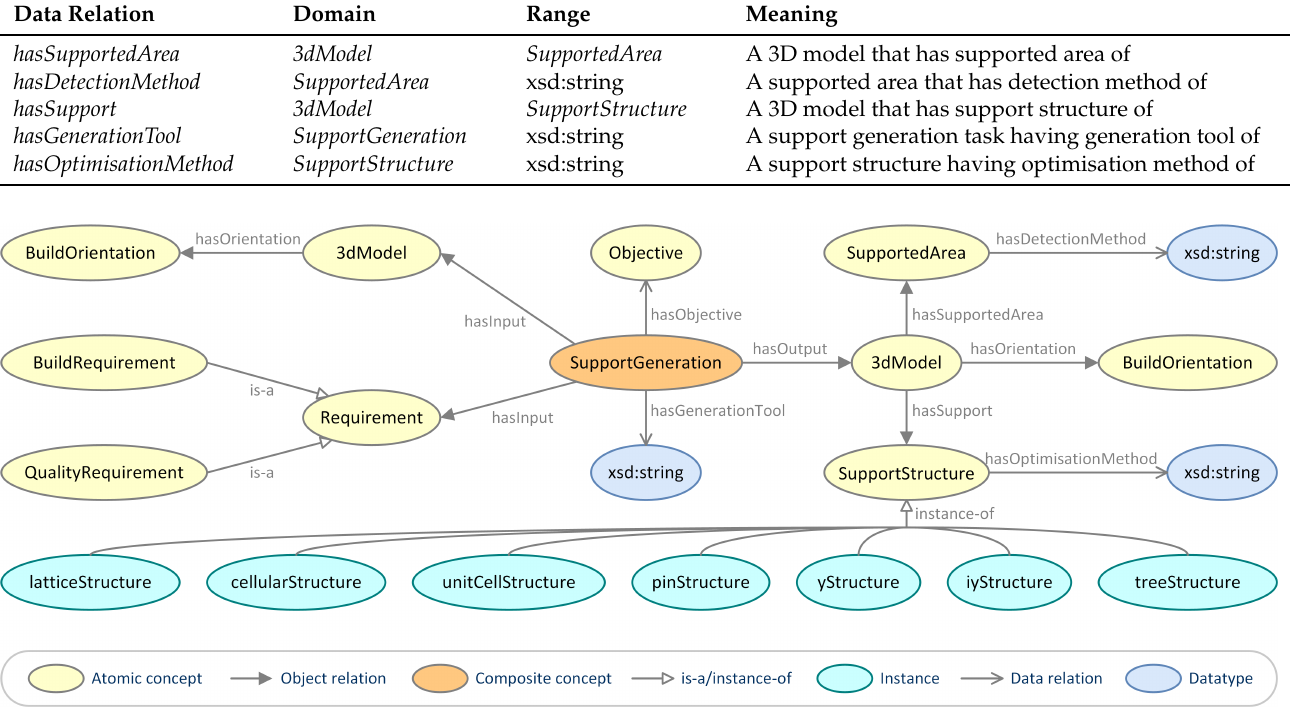
Figure 5. An ontological view of support generation for